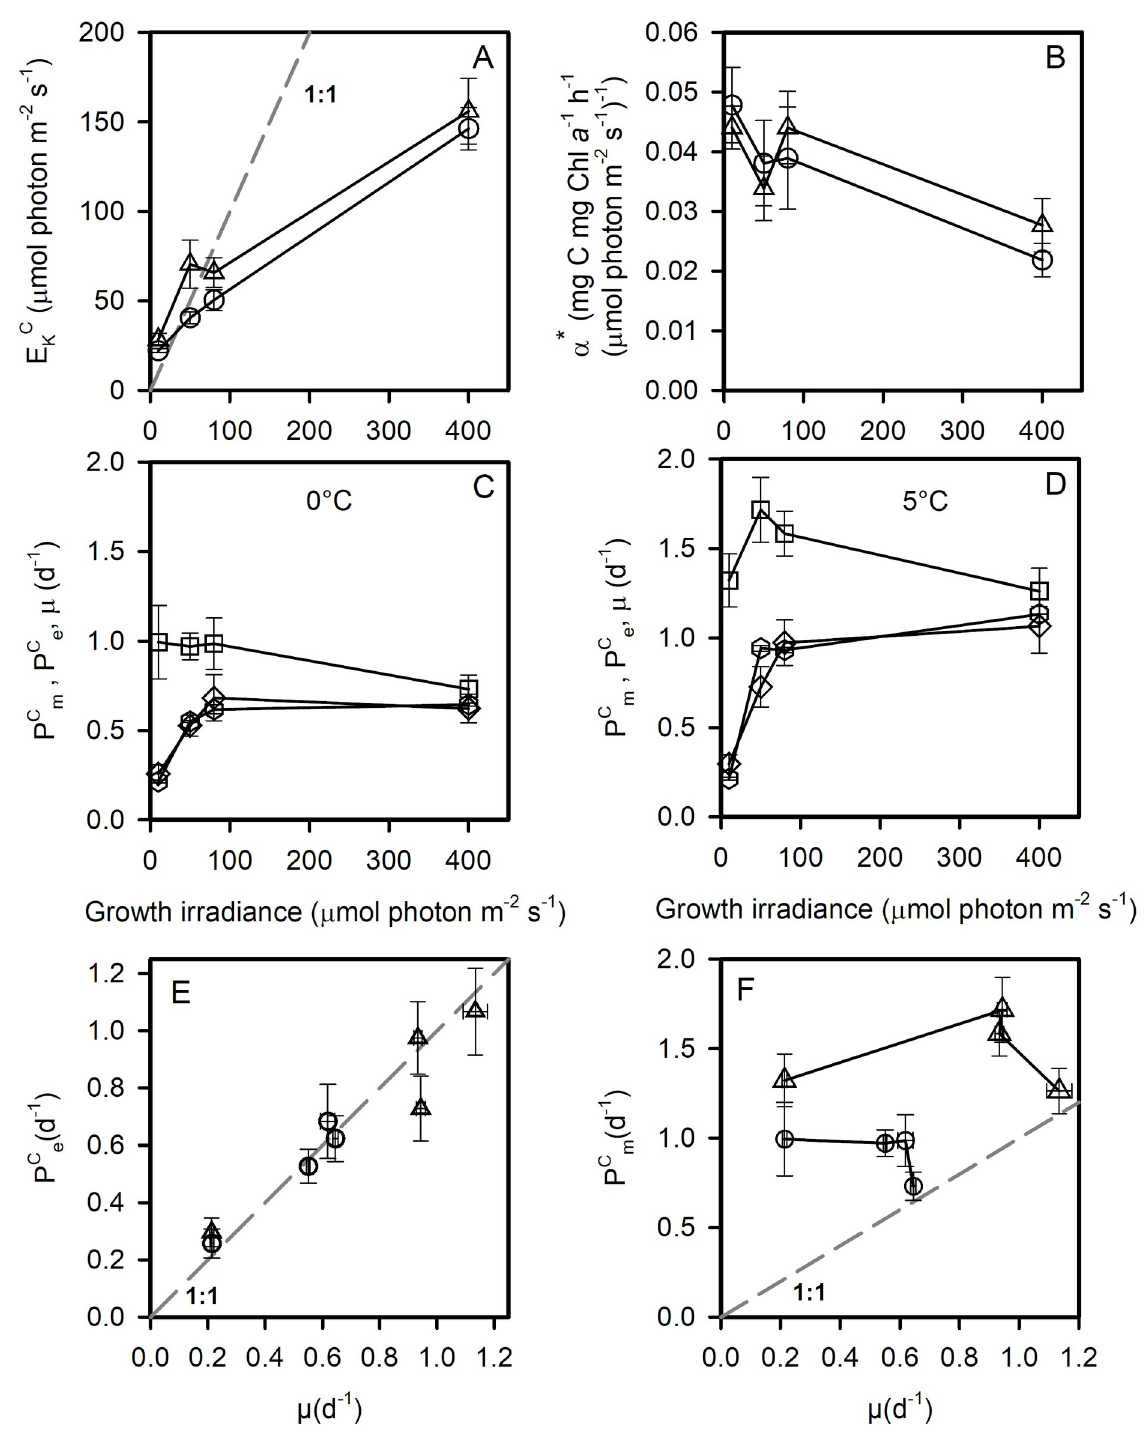
Fig 2. Photoacclimation of carbon fixation. E KC (A), and α � (B) versus growth irradiance at 0˚C (circles) and 5˚C (triangles). P C m (squares), P C e (diamonds) and μ (hexagons) versus growth irradiance at 0˚C (C) and 5˚C (D). P C e versus μ (E) and P C m versus μ at 0˚C (circles) and 5˚C (triangle). Each data point is the mean of 3 cultures measured each day during 3 consecutive days (50, 80, 400 μ mol photon m -2 s -1 ) or 2 days (10 μ mol photon m -2 s -1 ). In A, E, F, the dotted lines represent the 1:1 line Error bars represent standard deviations.